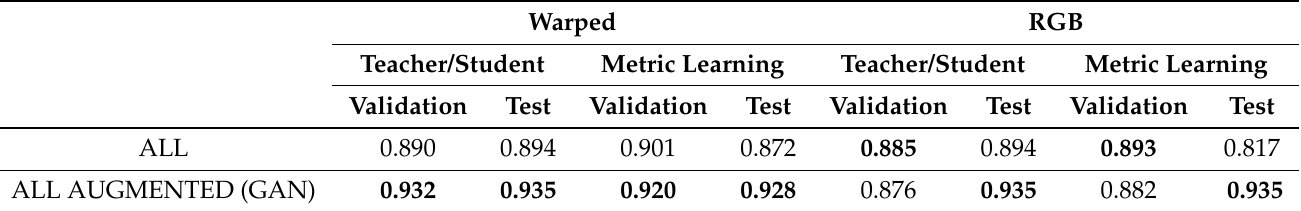
Table 7. Results with GAN-Augmented